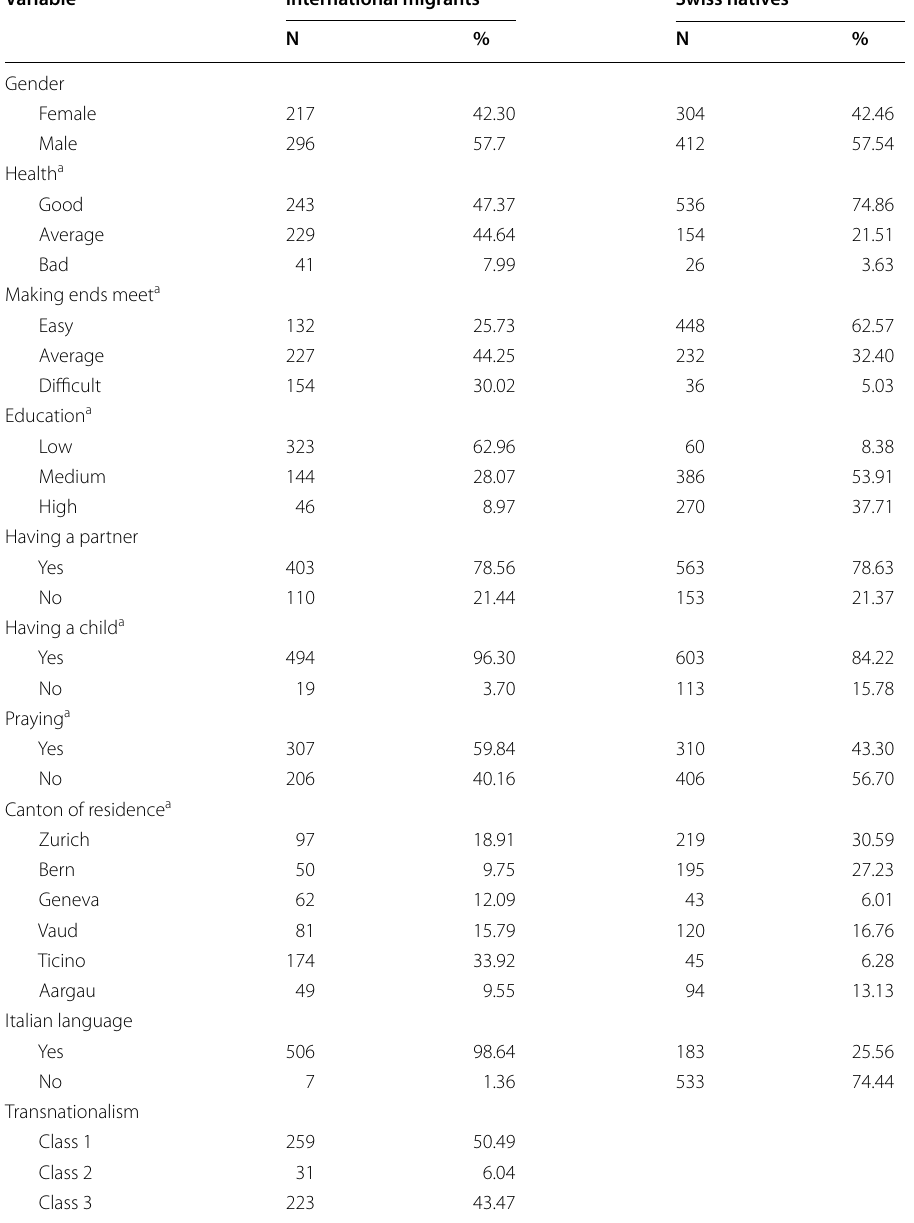
Source : TransAge Survey 2020 a Significant difference between international migrants and Swiss natives